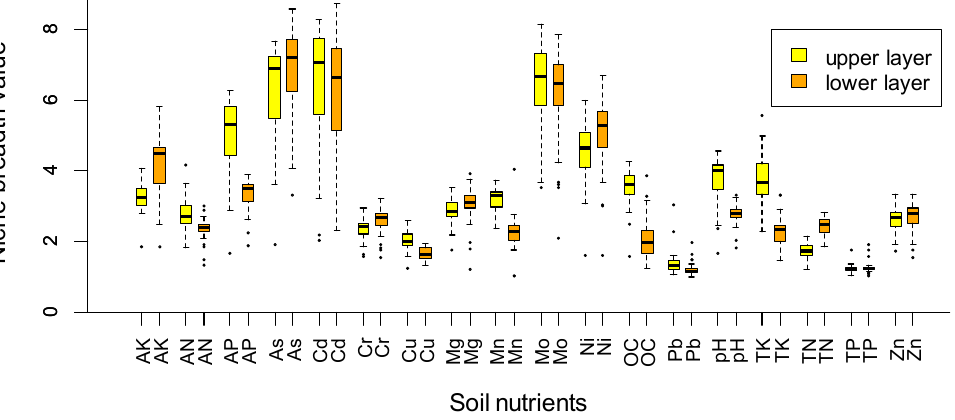
Figure 2. Boxplot of niche breadth values for 18 soil nutrients in two soil layers. The smaller the niche breadth for a given soil variable, the greater is the effect of that soil variable on the niche structure of the community.